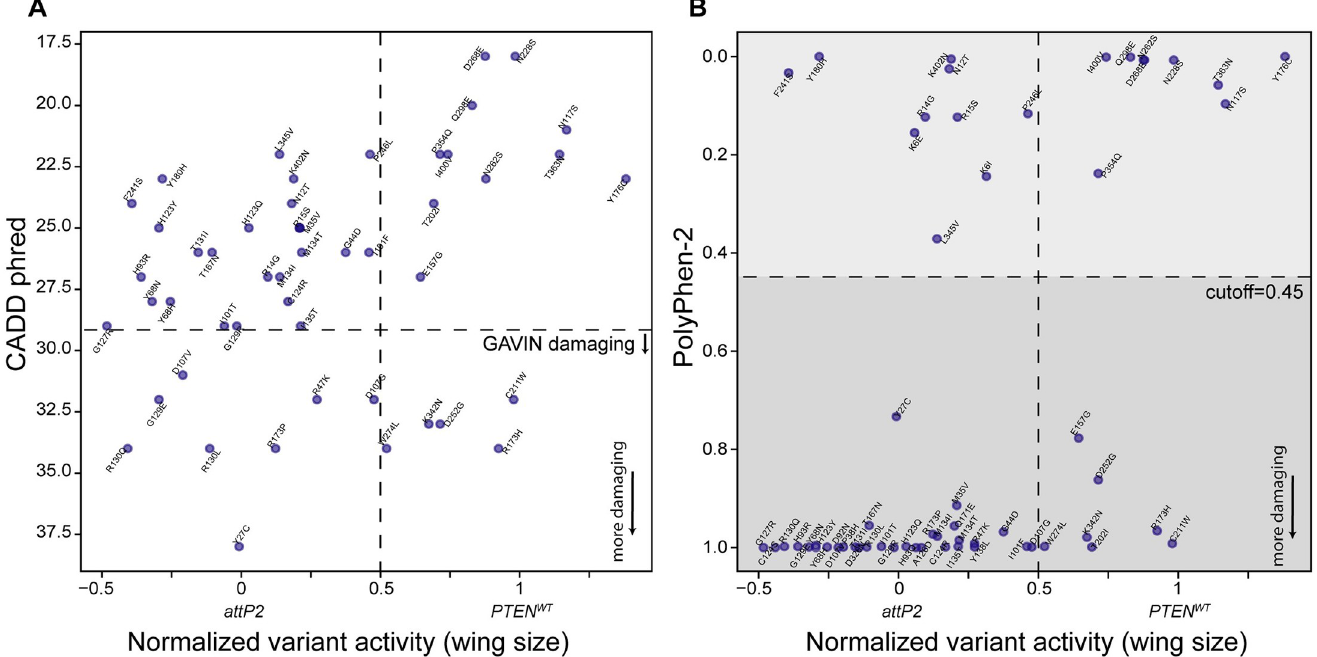
Fig 7. Comparison of PTEN variant function in wings with computational predictions. Graph showing normalized wing size data compared to CADD phred (A) and PolyPhen-2 (B) . A score above 0.45 indicates a likely damaging variant by PolyPhen-2 and is shaded dark grey. Each datum point indicates an individual normalized variant mean (where attP2 = 0 and PTEN-WT =